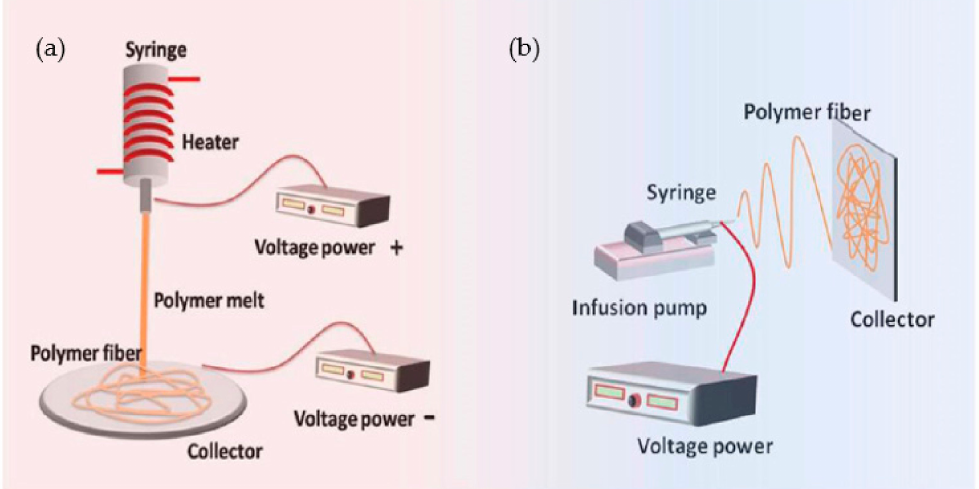
Figure 8. ( a ) Melt and ( b ) Solution Electrospinning